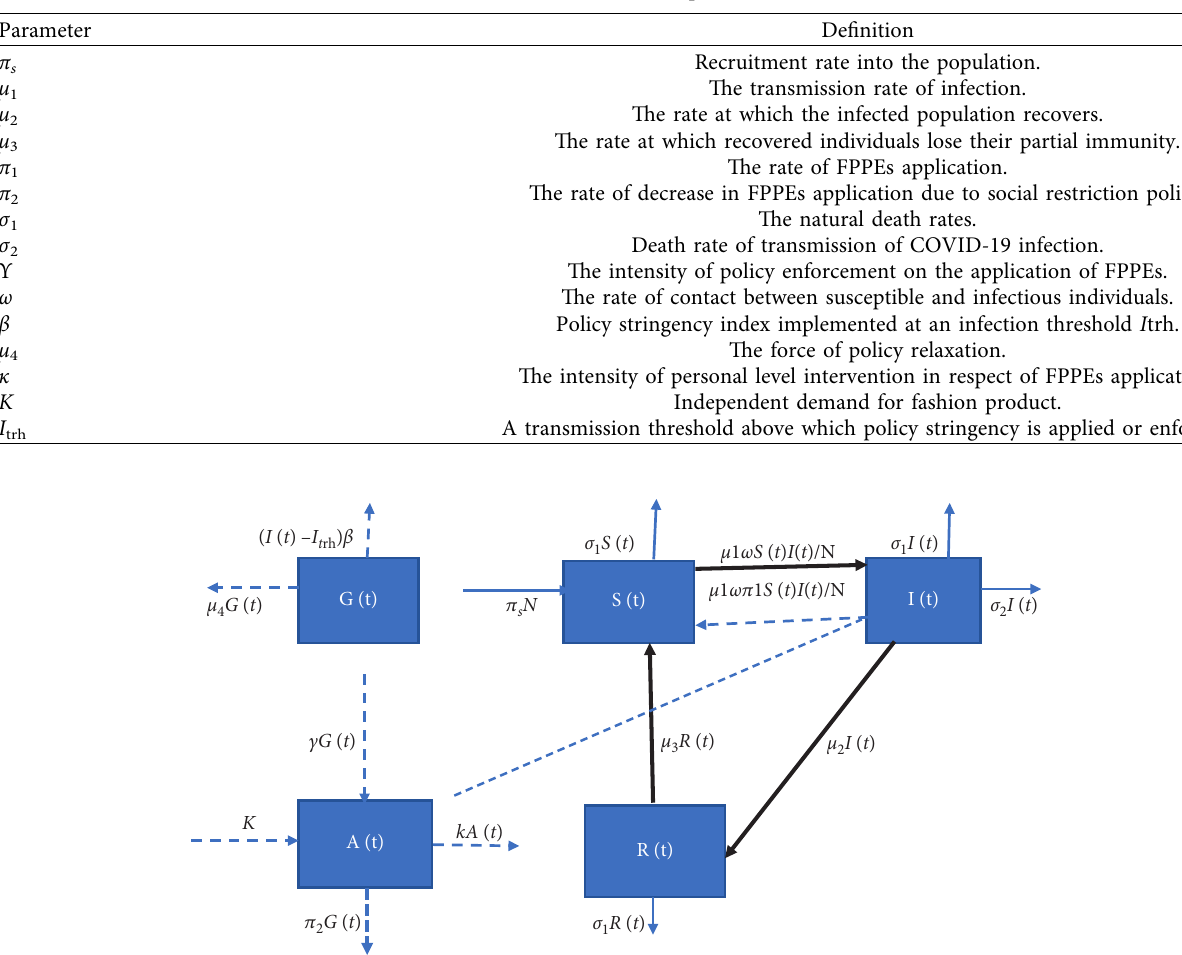
Table 2: Definition model parameters.